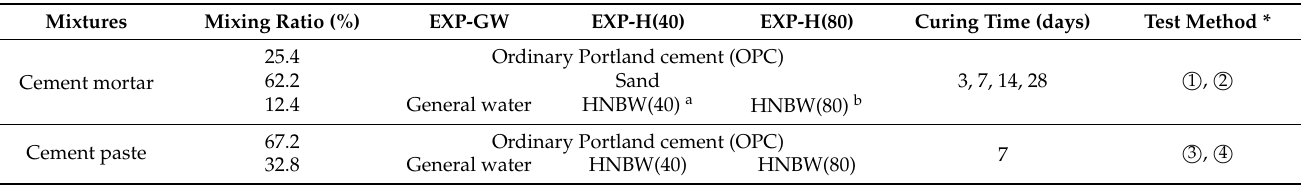
Table 1. Experimental conditions (fresh